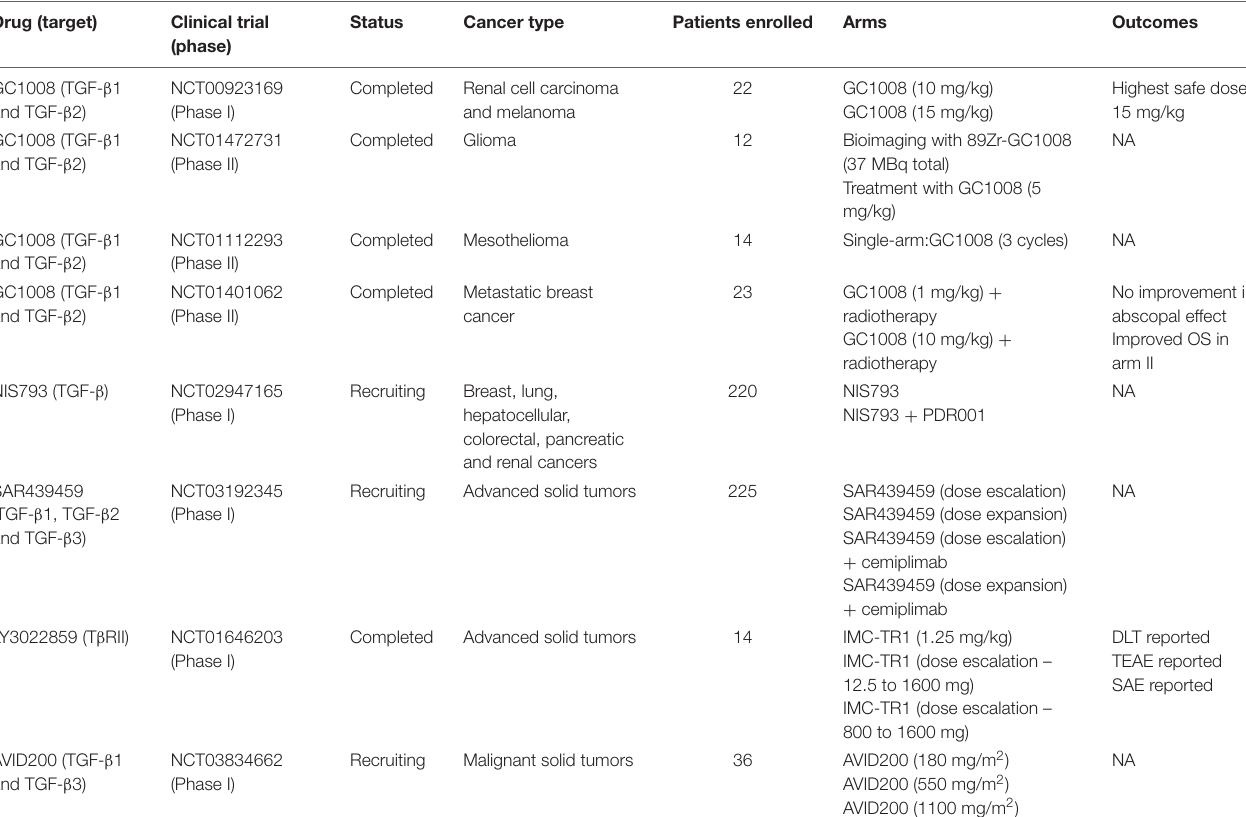
TABLE 3 | Overview of anti-TGF- β therapies based on the interference between ligand-receptor interactions used in cancer clinical trials. Drug (target) Clinical trial (phase)